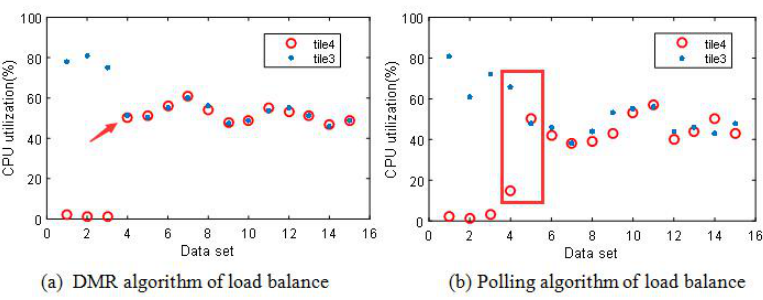
Figure 14. DMR vs